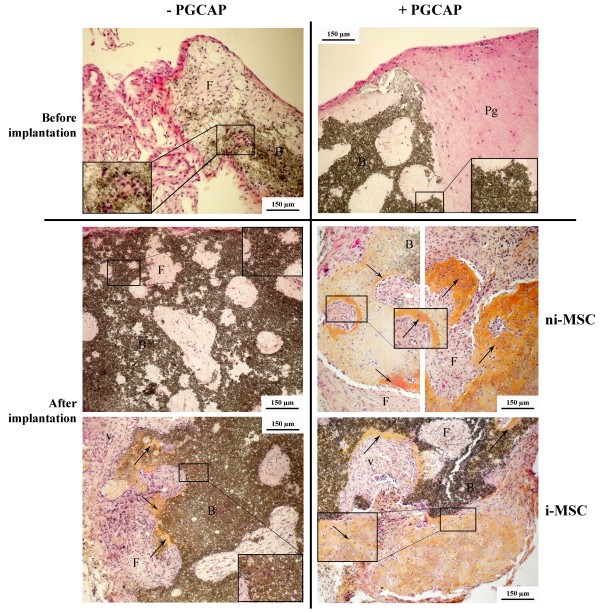
Ectopic implantation of MSC-loaded BMA embedded in PGCAP promotes bone formation in nude mice. Not induced-MSCs (ni-MSCs) or osteogenic induced-MSCs (i-MSCs) GFP+ loaded on BMA at high cell seeding density (200 × 103 cells per biomaterial) were embedded or not in PGCAP and grown for 21 days. Next, biomaterials were grafted on nude mice. After 21 days of in vitro culture (before implantation) and 28 days after grafting (after implantation), biomaterials were decalcified, embedded in paraffin, and stained with hematoxylin (nuclei), phloxin (cytoplasm), and safranin (matrix). Original magnification: ×10. Boxed area is magnified and points out cells that have migrated in biomaterials or area of bone formation. Arrows represent bone-like tissue characterized by osteocyte-like cells embedded in matrix stained by safranin. Each picture is representative of three independent experiments. B, biomaterial; F, fibroid tissue; Pg, platelet glue obtained from cryoprecipitation of apheresis platelet products; PGCAP, platelet glue obtained from cryoprecipitation of apheresis platelet products; V, vessels.